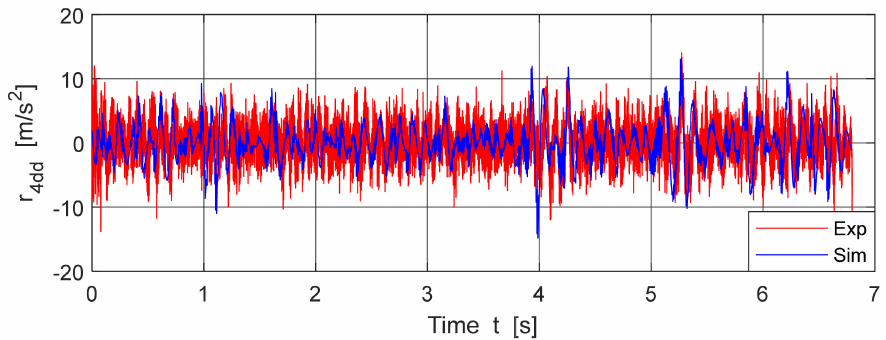
Figure 32. Acceleration on right front axle, V = 52.95 km/h.